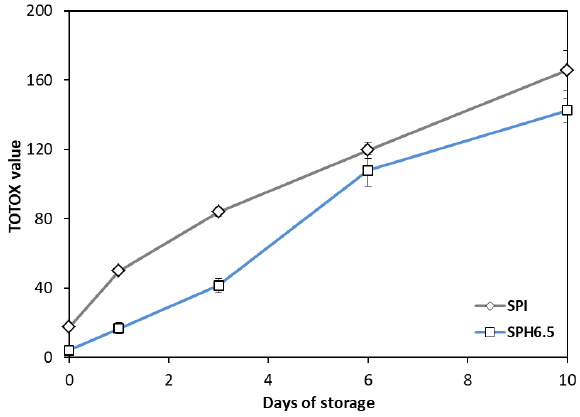
Figure 6. Evolution of Totox value for the optimal (SPH6.5) and control (SPI) emulsions.